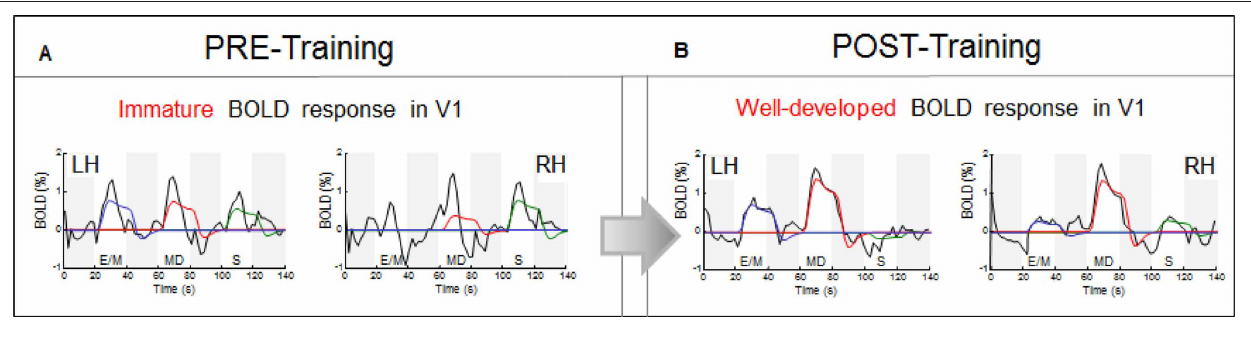
FIGURE 8 | Response waveform analysis in V1. The average time courses of BOLD activity (black lines) are shown for the sequence of the three task intervals (white bars); the four dark-gray bars indicate the 20s rest intervals separating E / M , MD , and S tasks. Immature and non-specific